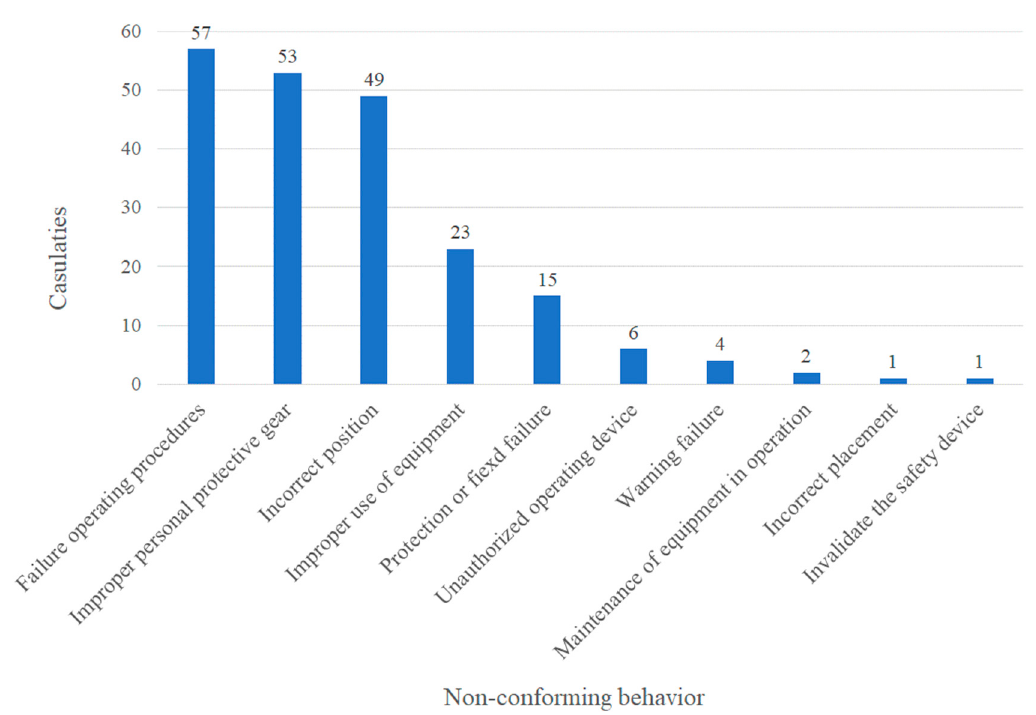
Figure 4. Statistics for non-standard acts.